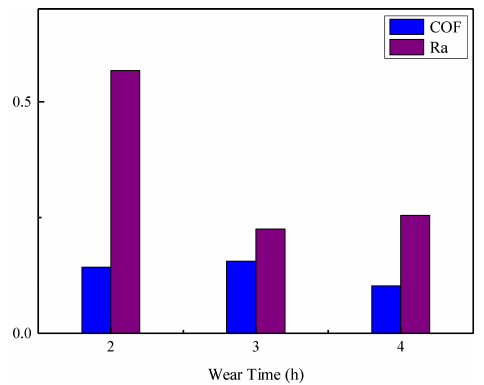
Figure 15. The COF and surface roughness for different wear